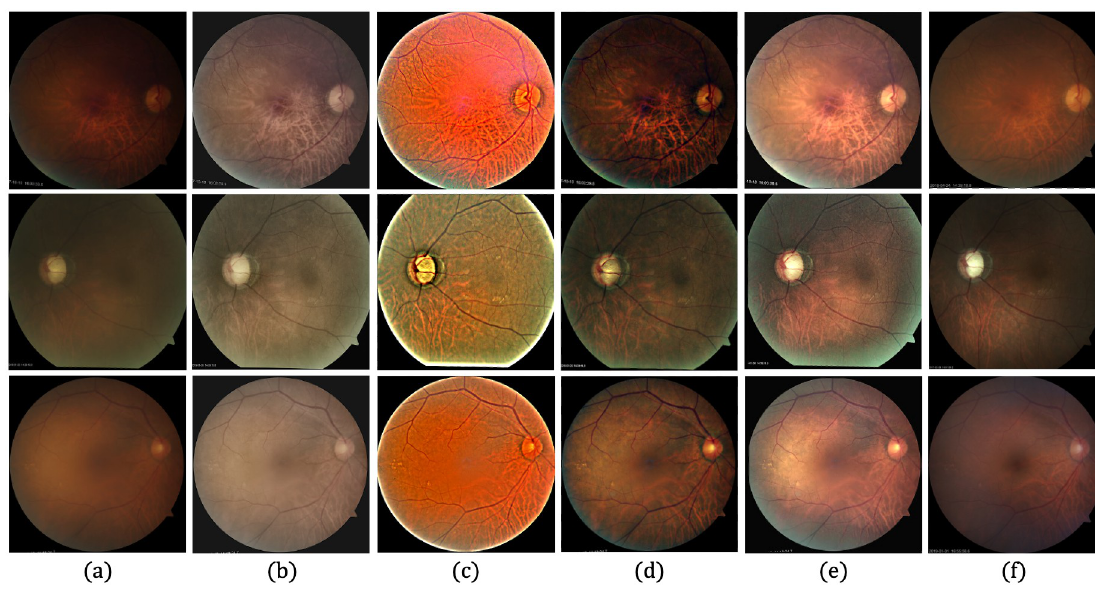
Fig 6. Qualitative comparison of three LQ image samples from the KBSMC private test dataset. (a) Input LQ images, and results using the methods of (b) Zhou et al. [42], (c) Gaudio et al. [88], (d) Dai et al. [89], (e) the proposed method, and (f) GT of (a).